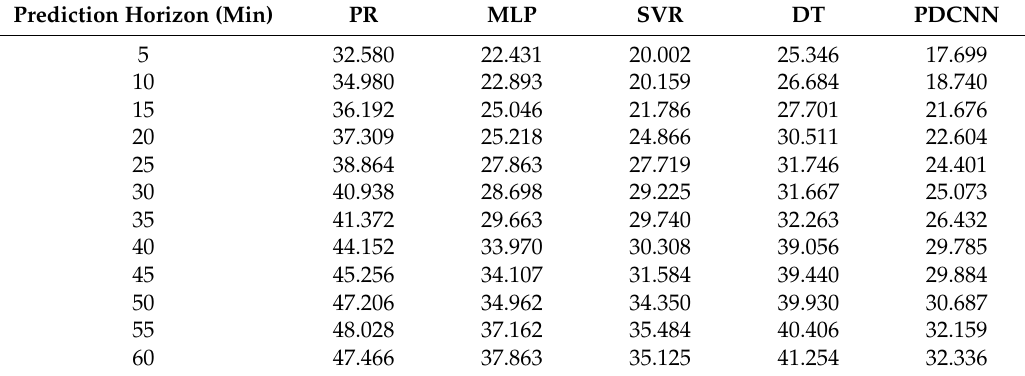
Table 4. Maximum Instantaneous Error (MIE) of Prediction Models for Different Time Horizons (m/s). Prediction Horizon (Min) PR MLP SVR DT PDCNN